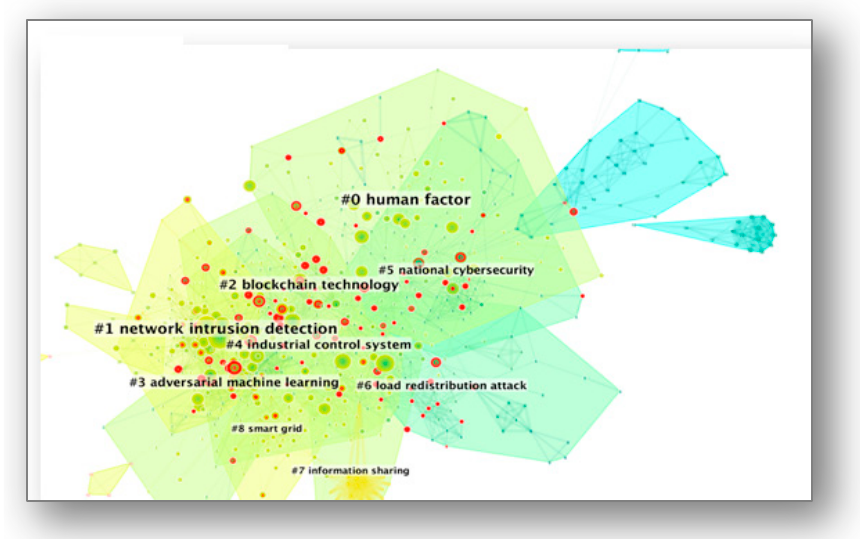
Figure 6. The interconnection of major lines for cybersecurity.